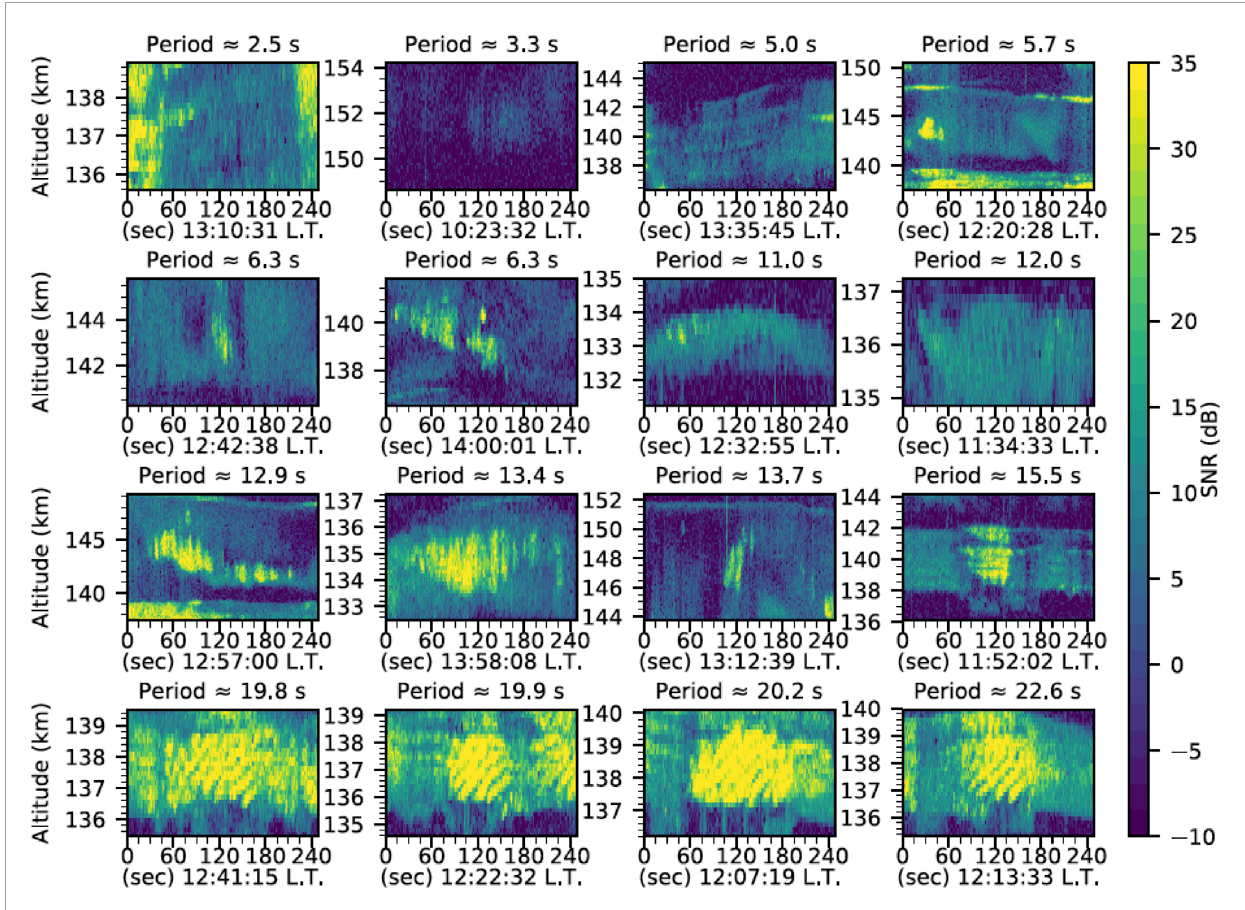
FIGURE 3 High-resolution altitude-time SNR showing examples of sub-minute fluctuations in the 150-km region above Jicamarca on 30-January-2016. Dominant periods for each selected time-altitude window are indicated. (from Reyes, 2017, Figure 5.14).